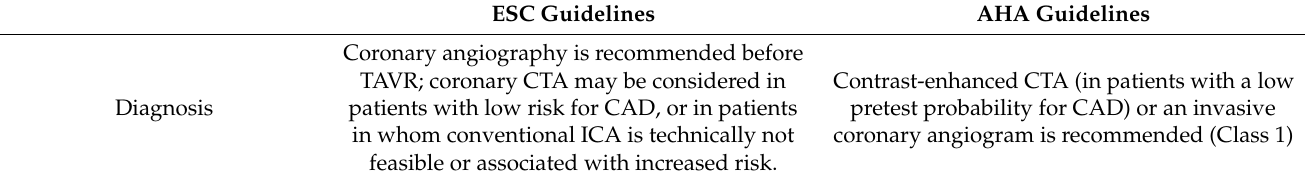
Table 2. Management of CAD in patients undergoing